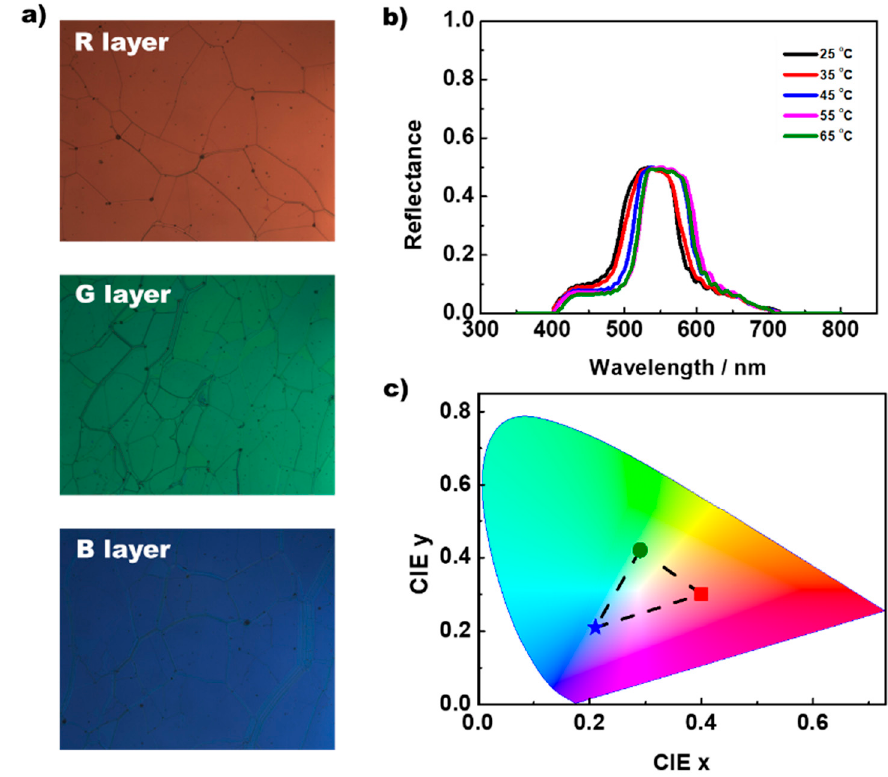
Figure 2. ( a ) Typical polarized optical microscopy images of the red (R), green (G), and blue (B) Ch layers. The images were captured in the reflective mode. ( b ) Typical reflectance curves for the G Ch layers, obtained at different temperatures. ( c ) Color coordinates of the reflectance spectra of the fabricated R, G, and B Ch layers. Here, the reflectance spectra of the fabricated R, G, and B Ch layers were obtained by illuminating the layers with normally incident light.